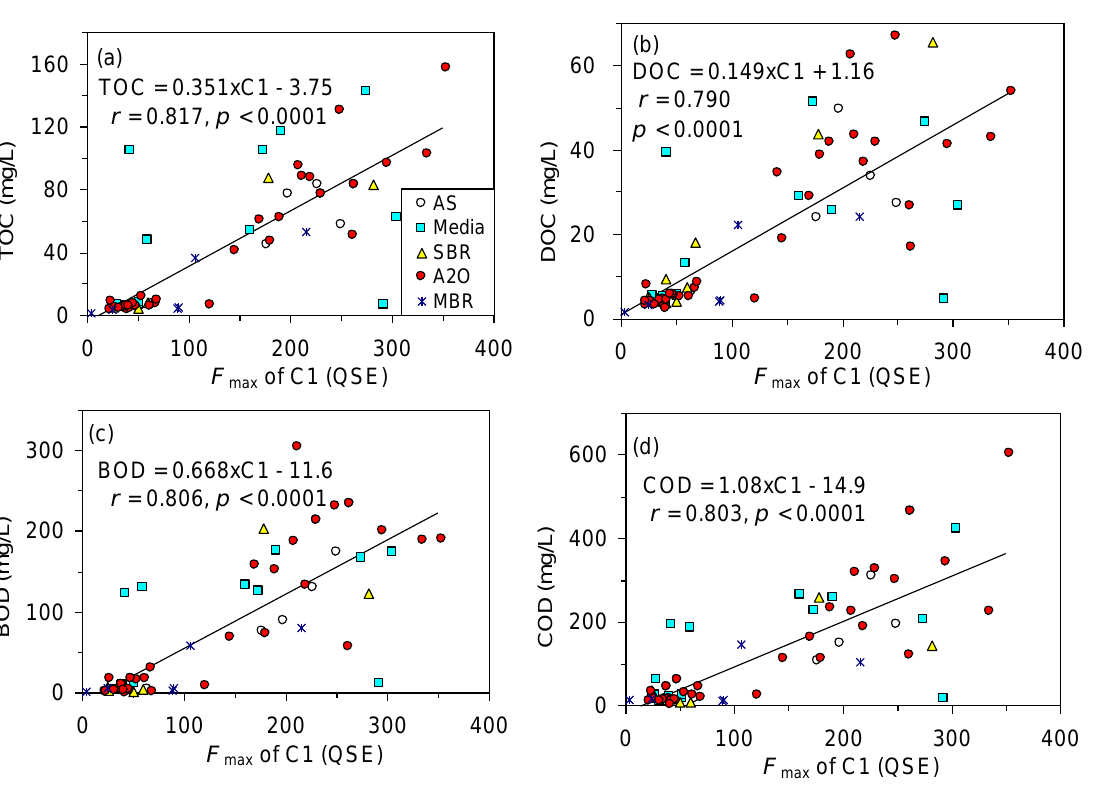
Figure 4. Relationships between the fluorescence intensity of C1 and ( a ) TOC, ( b ) DOC, ( c ) BOD, and ( d )